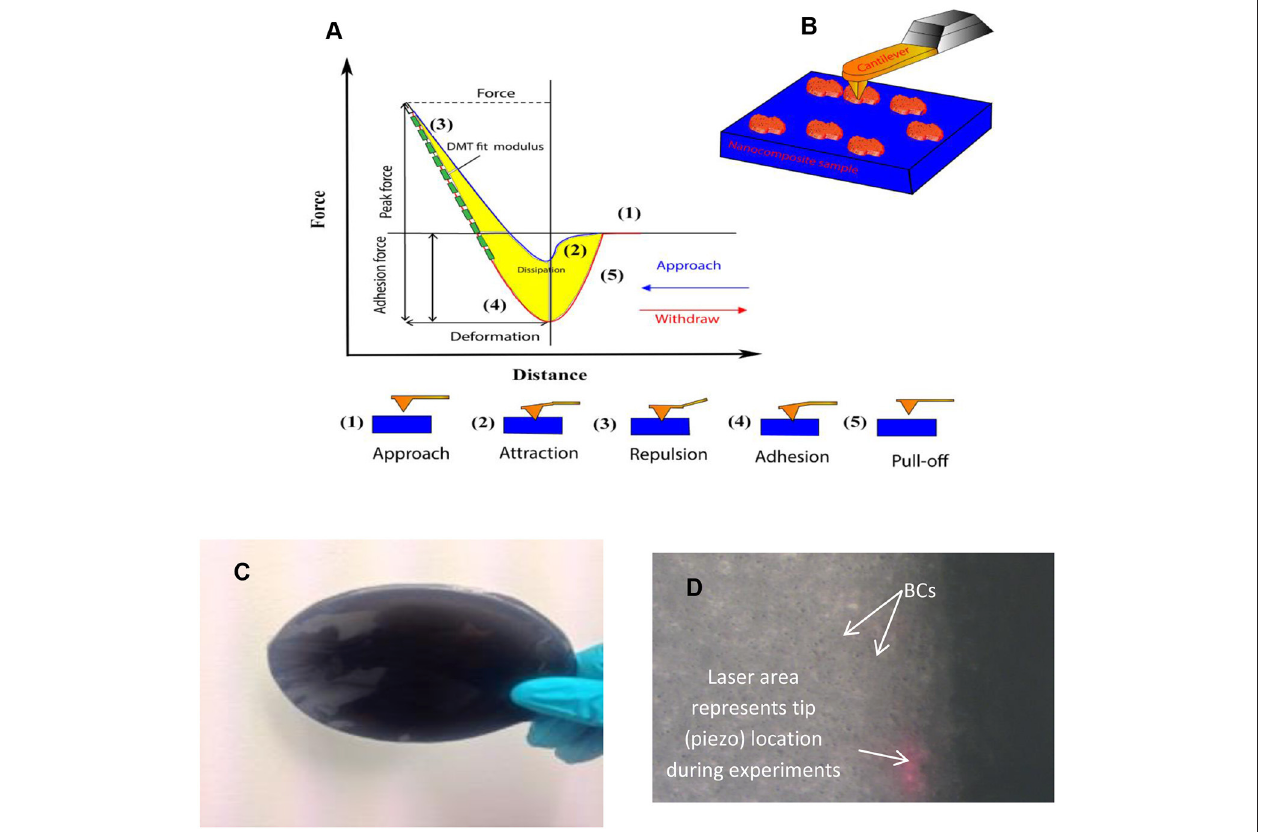
FIGURE 1 | (A) schematic diagram of force vs. tip-sample separation obtained from AFM tapping on the sample surface where the separation is calculated from z peizo position and cantilever deflection (Blue and red curves denote loading and unloading portions, respectively and green dash line is obtained by DMT model fitting. The minimum force in the withdraw curve is used for mapping adhesion force. Steps from (1) to (5) represent tip-sample interactions throughout 0.5ms (Pakzad et al., 2012), Reprinted with copyright permission from Elsevier, (B) schematic diagram representing a probe tapping process for nanocomposite samples, (C) typical PVA/BC nanocomposite film, and (D) probe-tip location on the film surface of PVA/BC nanocomposites.